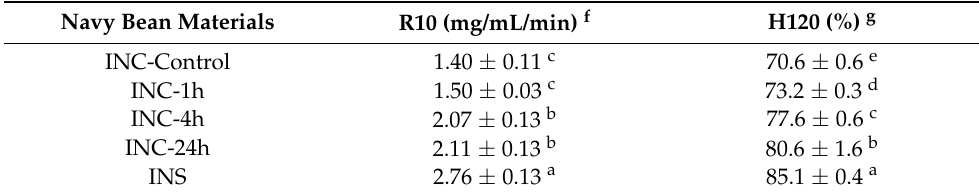
Figure 3. In vitro starch hydrolysis curves of cooked samples of control INCs ( ) and INCs pre-treated with pepsin for 1 h ( ), 4 h ( ), and 24 h ( ). INS ( ) was included as a reference. Errors bars represent the standard deviations. Table 2. Kinetic parameters of in vitro starch digestion of cooked samples of INS, control INCs, and pepsin-treated